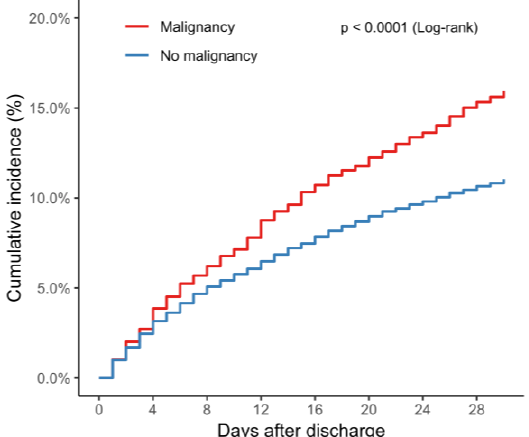
Figure 1. Cumulative rates of 30-day readmissions according to the presence of malignancy. Data show unadjusted 30-day readmission rate in TTS patients with malignancy (red) and in those without malignancy (blue). Abbreviations: TTS, Takotsubo syndrome. Table 3. Independent Predictors of 30-Day Readmission After Index Hospitalization with Takotsubo Syndrome. Variables Unadjusted OR Lower CI Higher CI p Value